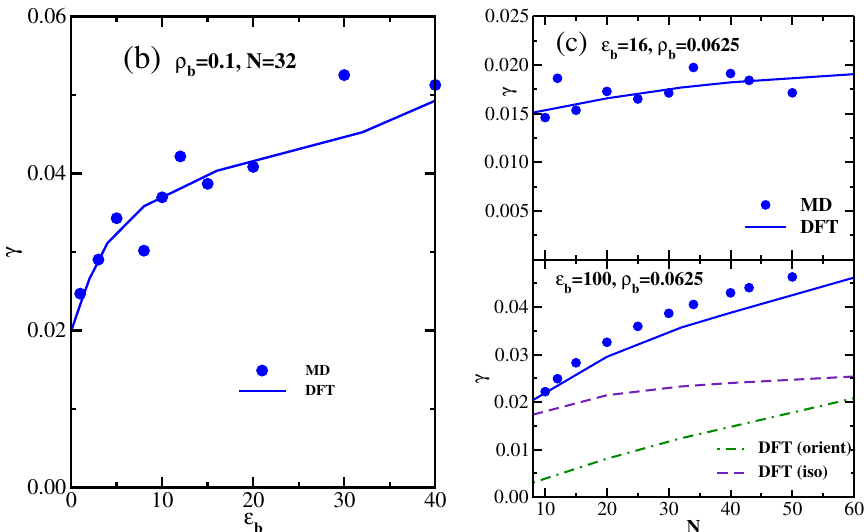
Figure 7. ( a ) Monomer density profiles ρ ( z ) across the film for L z = 40 and four values of the stiffness parameter (cid:101) b = 1,5,10 and 30, choosing N = 32 and ρ = 0.1 in the MD simulation. The MD profiles are the noisy curves, while the corresponding DFT calculations were done choosing a chemical potential for which the bulk density ρ b coincides with the density ρ middle in the middle of the film, at z = L z /2. These densities ρ middle are quoted in the key of the figure, and the smooth lines show the DFT profiles. Note that the curves are shifted vertically by 0.015 relative to each other for the sake of better visibility; ( b ) Surface tension γ (Equation (22)) plotted vs. (cid:101) b / k B T for the case ρ b = 0.1 and N = 32, comparing MD results (dots) with DFT predictions (line); ( c ) Same as (b), but for the case ρ b = 0.0625, (cid:101) b = 16 (upper part) and (cid:101) b = 100 (lower part), plotted vs. chain length N . The contributions of the isotropic and orientational terms are shown as broken and dash-dotted curves, respectively. Reproduced from [43] with the permission of AIP